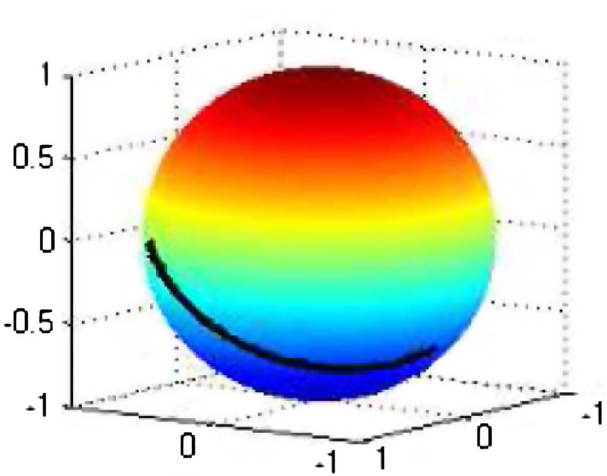
Figure 4. The shapes of interpolation are simulated with MATLAB R2010a: (a) Quaternion interpolation between the two key frames in Euclidean space, there are 50 interpolated frames, (b) velocity graph quaternion interpolation [12].